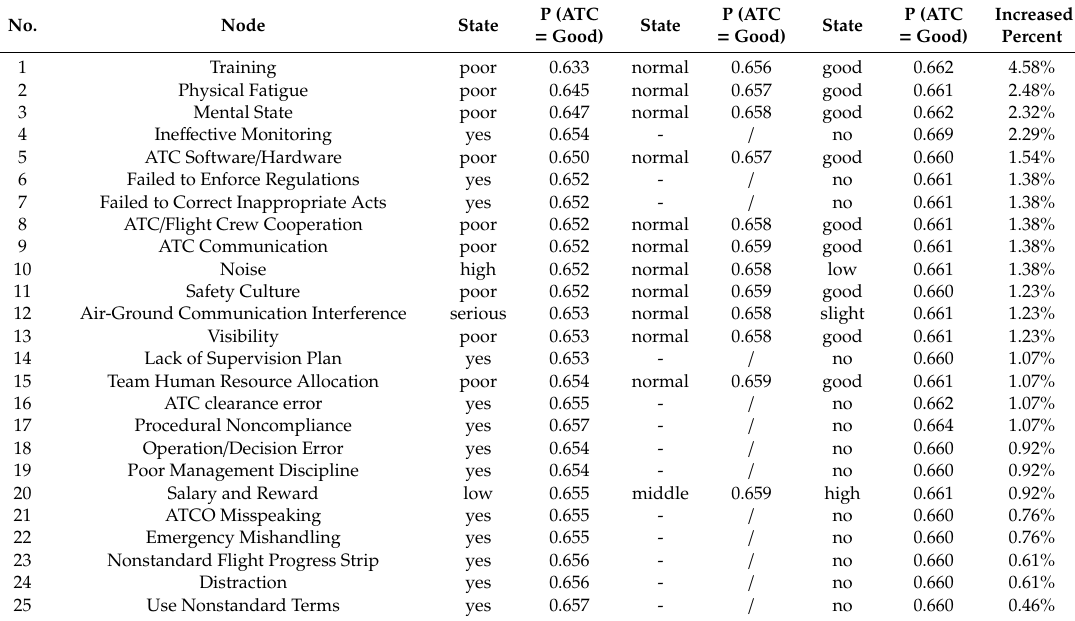
Table 5. Computation results of changing states of influence